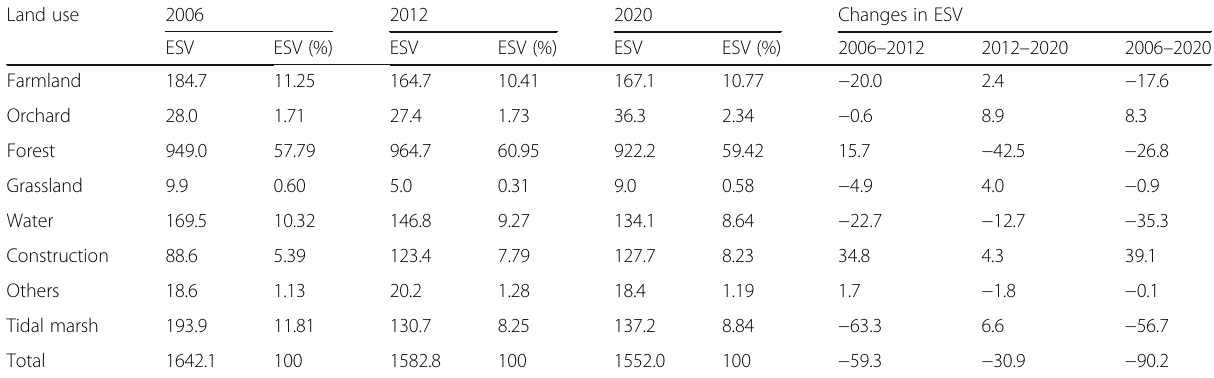
Table 7 Changes in ecosystem service values in the Dinghai District (unit; million Chinese yuan/year) Land use